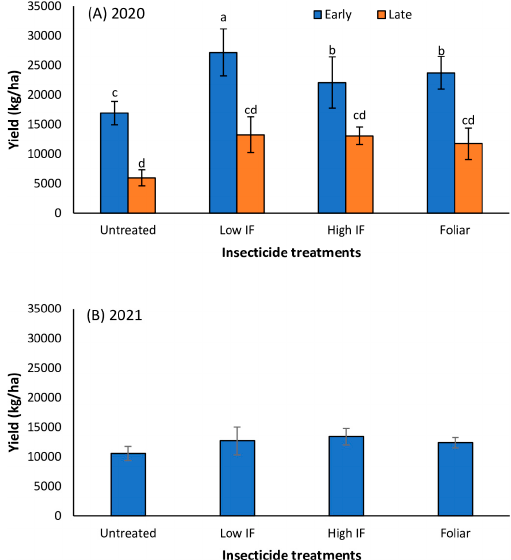
Figure 6. Mean (±SE) forage yield (kg/ha on a dry weight basis) in early and late planted forage sorghum treated with flupyradifurone in-furrow (IF) or foliar in 2020 ( A ) and 2021 ( B ) in Florence, SC. Bars with different letters are significantly different ( p < 0.05; Turkey’s HSD test) among all four insecticide treatments and the two planting dates. Note: forage sorghum in early planted plots in the 2021 study were not harvested due to error at planting.